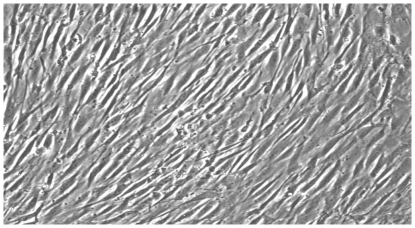
Phase contrast microscope image of control human Mesenchymal stem cells (hMSC) culture after passage 5.Magnification 4×.